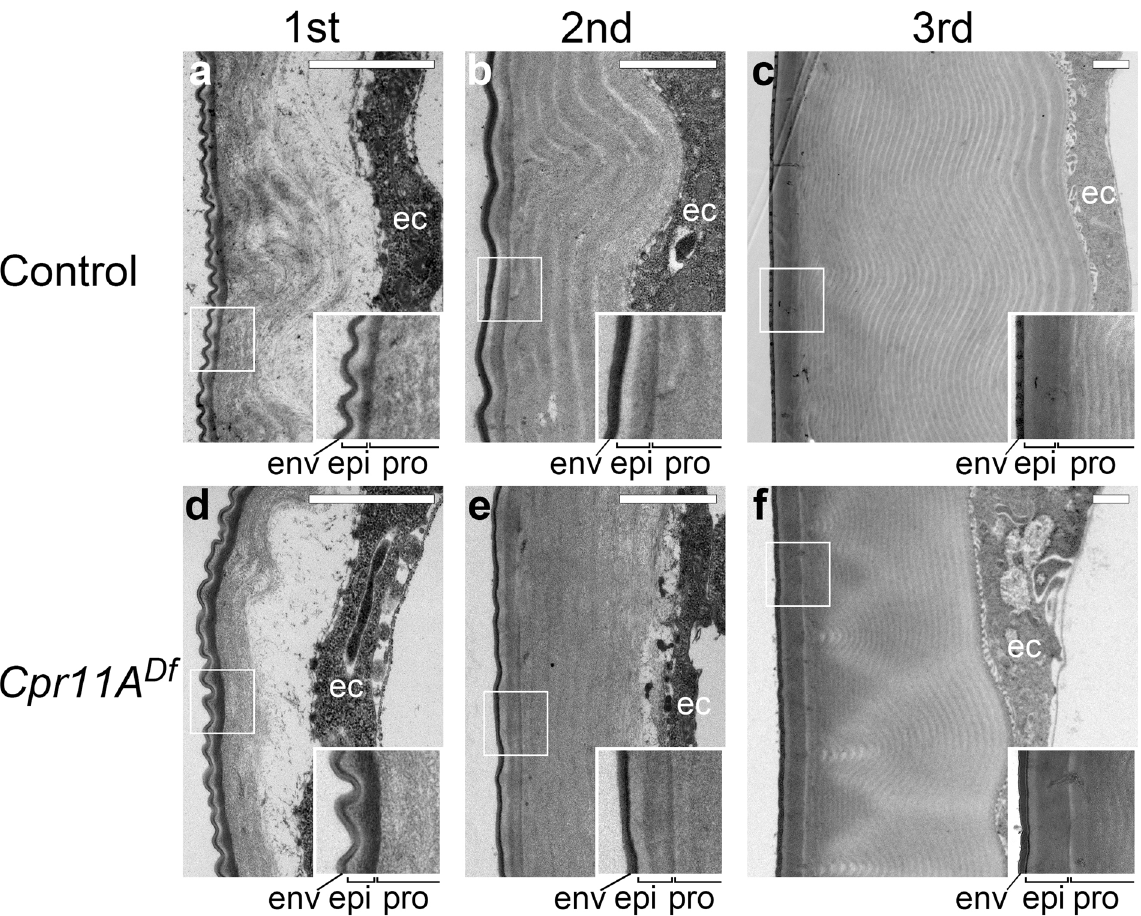
Fig. 6 Cuticle ultrastructure. Transmission electron micrographs of cuticle cross-sections perpendicular to the anteroposterior axis of the control ( a – c ) and the Cpr11A Df mutant ( d – f ) in fi rst ( a , d ), second ( b , e ) and third ( c , f ) instars. Apical (external) is to the left. ec, epidermal cells. Bars, 1 μ m. Boxed regions are magni fi ed on the right-lower corner of each panel. env, envelop; epi, epicuticle; pro, fi ne protrusions, which corresponded to the meshwork of Cpr11A:EGFP enrichment observed in surface views (Fig. 4d).